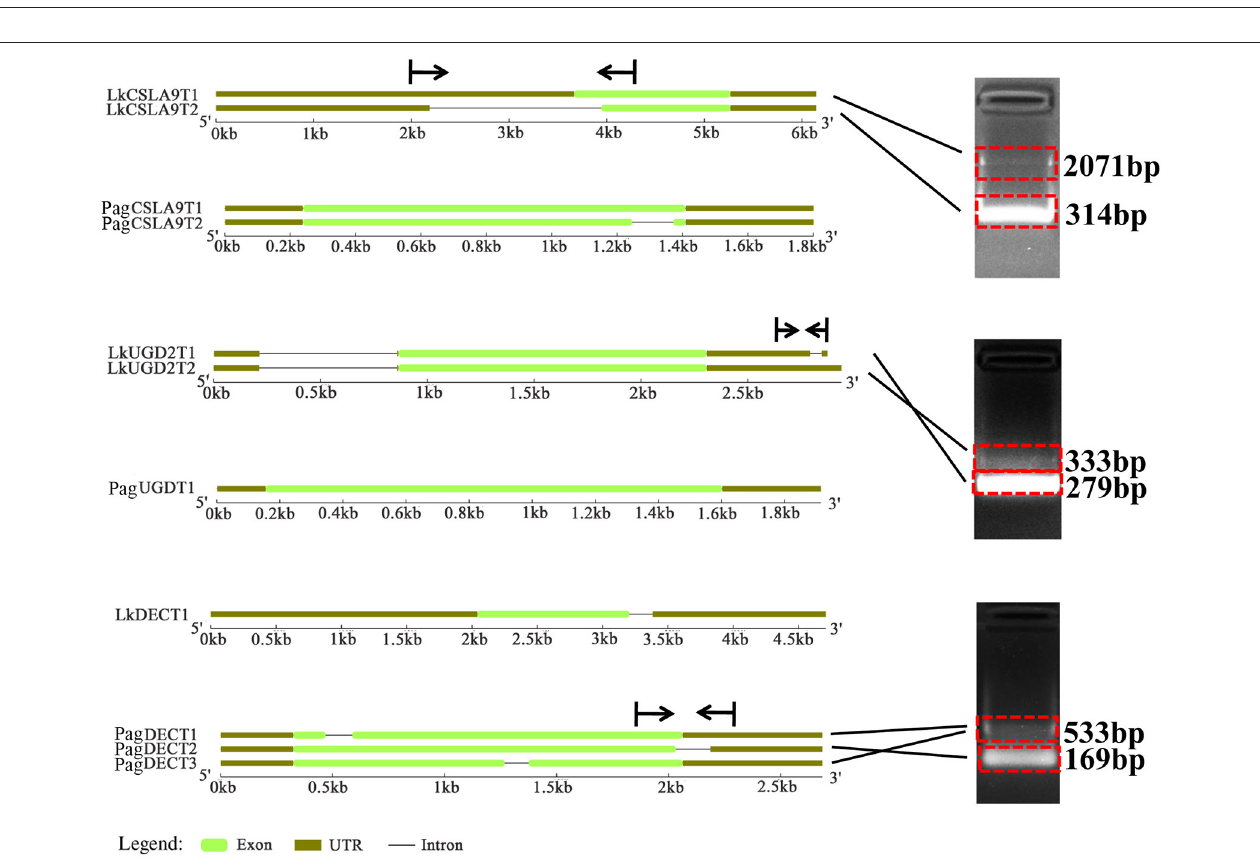
FIGURE 8 | Comparison of the gene structure for three common genes and their variants in the two tree species. Vertical lines and arrows indicate the position of designed primers and amplification direction of fragments, respectively.